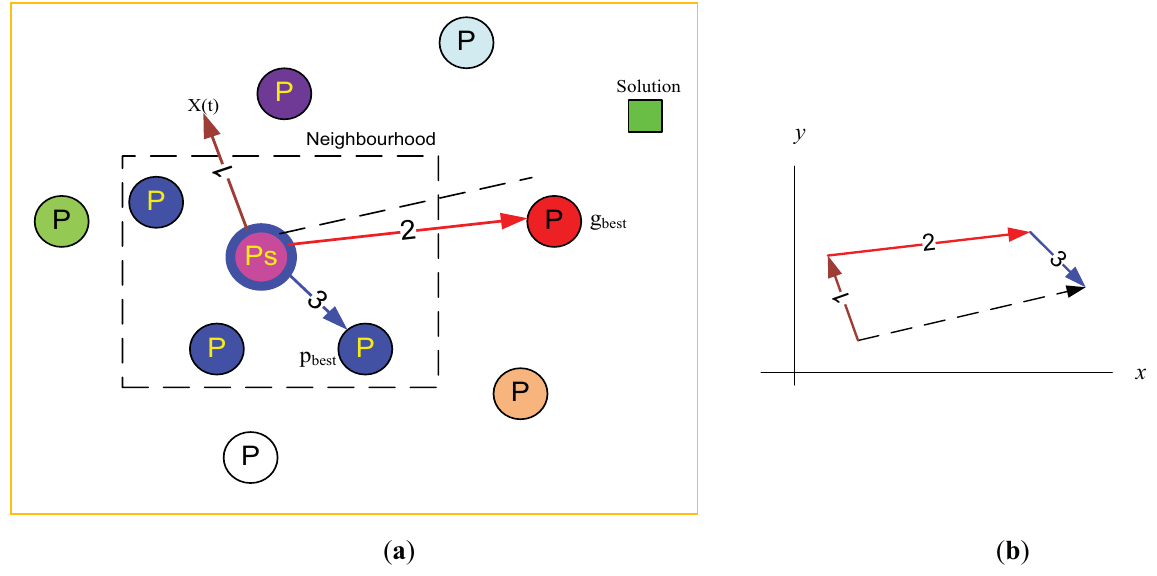
Figure 1. (a) Particle local and global best. (b) Particle vector